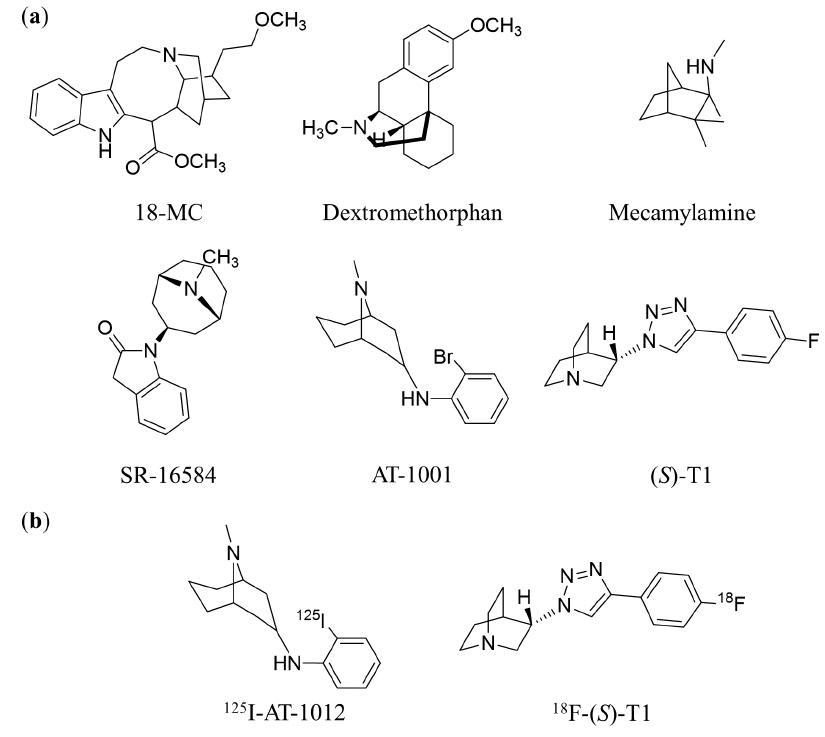
Figure 1. Structures of ( a ) α 3 β 4 nAChR ligands and ( b ) radio-imaging agents.